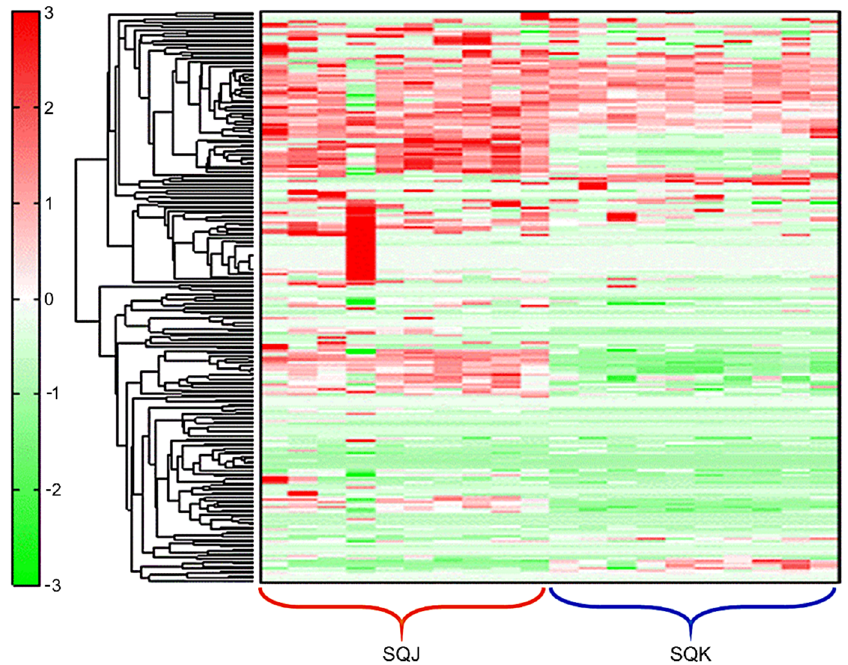
Figure 2. A heat map of hierarchical cluster analysis (HCA) comparing metabolites between SQJ and SQK. The y-axis shows peaks determined by HCA. The distances between peaks are displayed in a tree diagram; the degrees of red and green color indicate higher and lower contents of metabolites than the average, respectively.